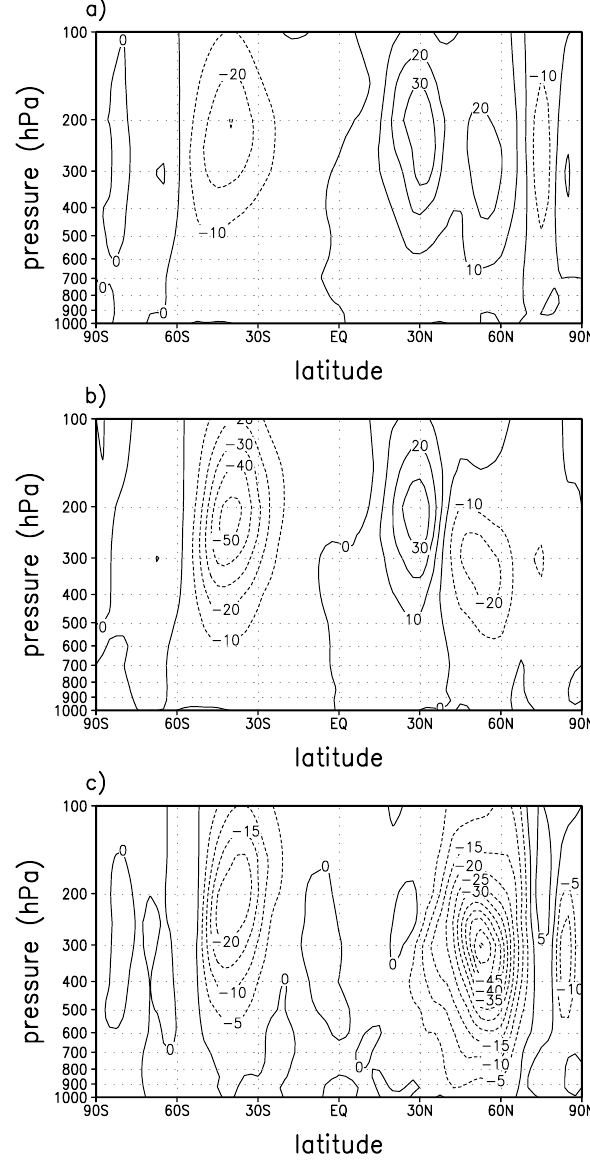
Fig. 6. Zonally-averaged eddy heat flux for January: (a) 1996, (b) 1998, and (c) Difference (1998 minus 1996). Units, ms − 1 K.